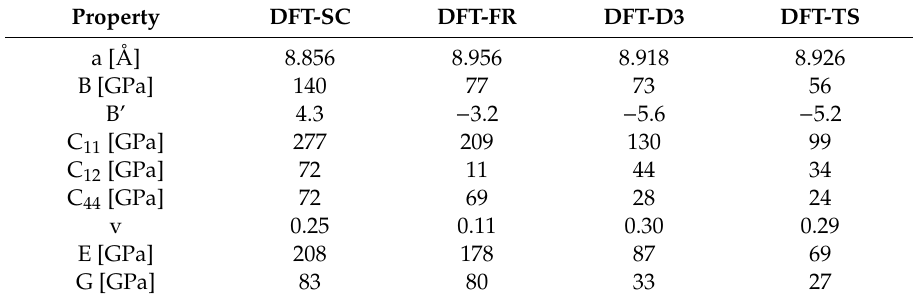
Table 2. Comparison of the calculated lattice parameter a and the elastic properties (B: Bulk modulus, B’: pressure derivative of B, C ij : Elastic constants, ν : Poisson’s ratio, E: Elastic modulus, G: Shear modulus) of HfV 2 O 7 using DFT. Calculations were performed with structural relaxation only at equilibrium volume (SC), at every volume without dispersion correction (FR), as well as with dispersion correction, by applying methods according to Grimme et al. [16] (D3) and Tkatchenko and Sche ffl er [28] (TS). Property DFT-SC DFT-FR DFT-D3 DFT-TS a [Å] 8.856 8.956 8.918 8.926 B [GPa] 140 77 73 56 B’ 4.3 − 3.2 − 5.2 C 11 [GPa] 277 209 130 99 C 12 [GPa] 72 11 44 34 C 44 [GPa] 72 69 28 24 v 0.25 0.11 0.30 0.29 E [GPa] 208 178 87 69 G [GPa]